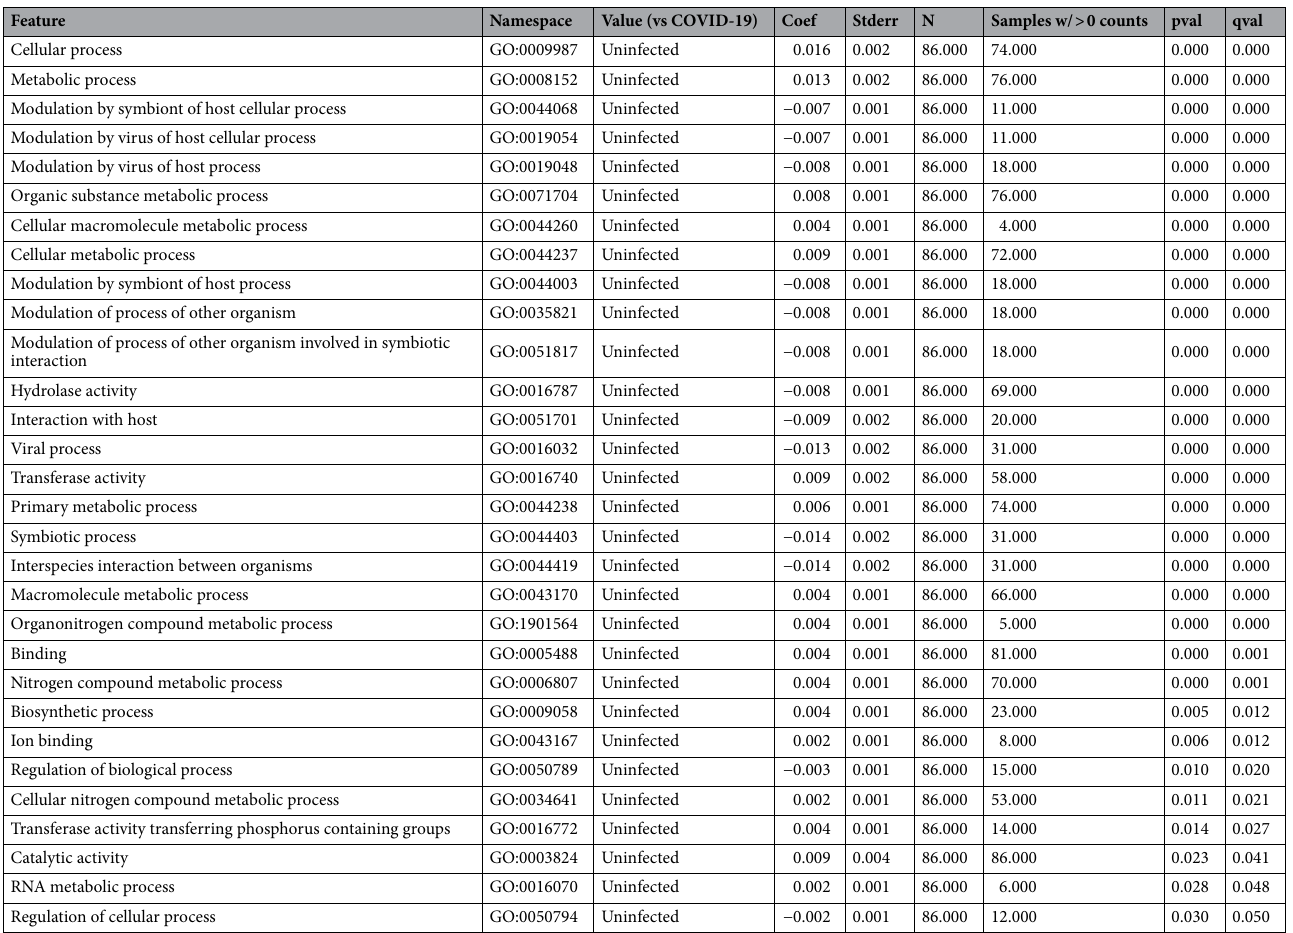
Table 3. MaAsLin2-derived significant gene ontologies associated with COVID-19 (n = 32) when compared to the uninfected (n = 29) cohort. Comparisons were conducted using compositional transformed and CLR normalized count matrices, controlled for the random effects of publication and patient, and adjusted for multiple test comparisons using the Benjamini Hochberg correction method. A full list of statistically significant GO terms in COVID-19 vs. Uninfected can be found in Suppl. Table